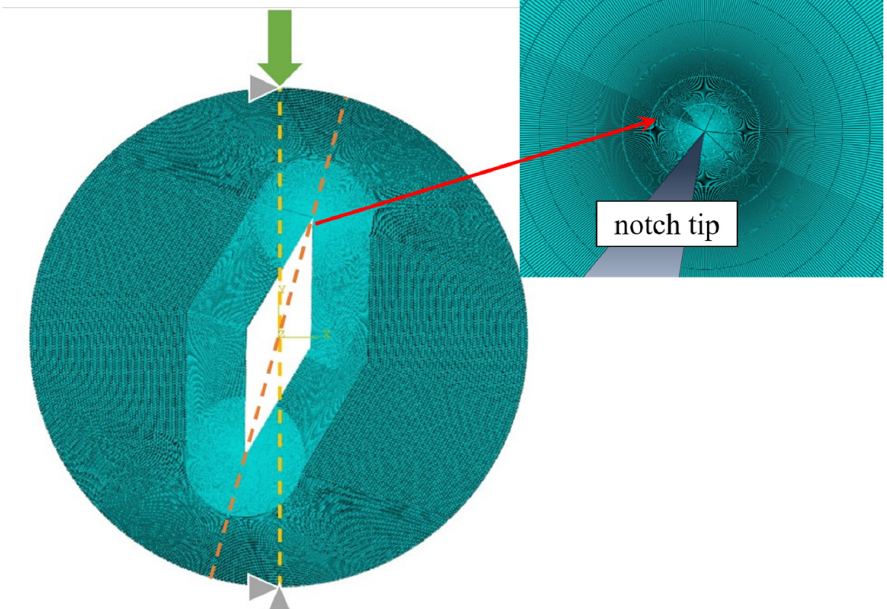
Figure 9. A typical mesh pattern, loading and boundary conditions for the SVNBD samples.